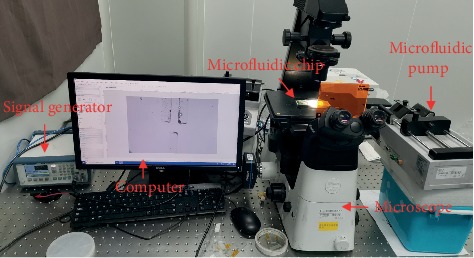
Manipulation system consisting of a signal generator, a microscope, and two microfluidic pumps.